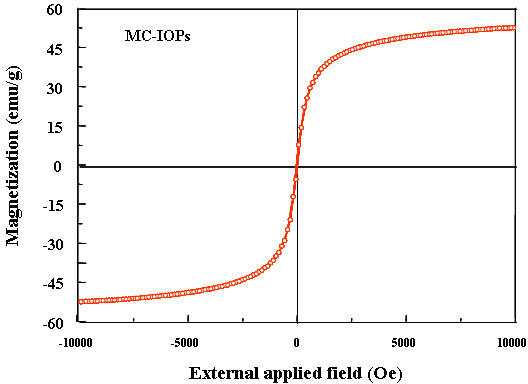
Magnetisation curve of magnetite obtained by VSM at room temperature.